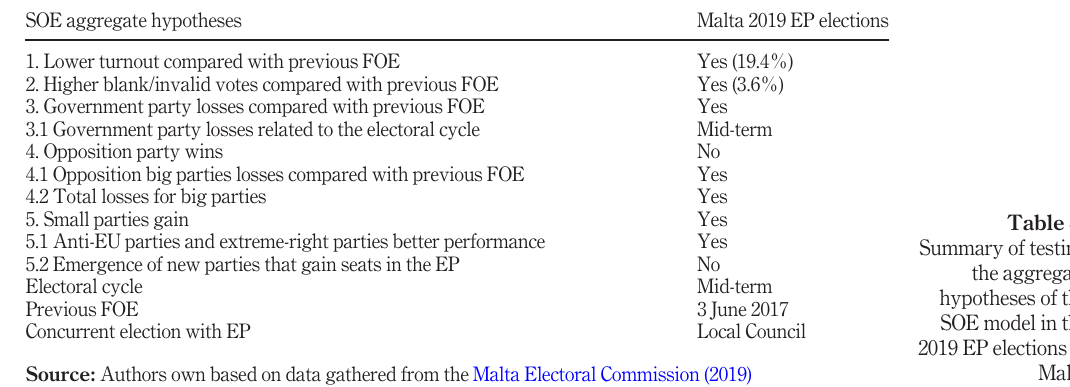
Table 4. Summary of